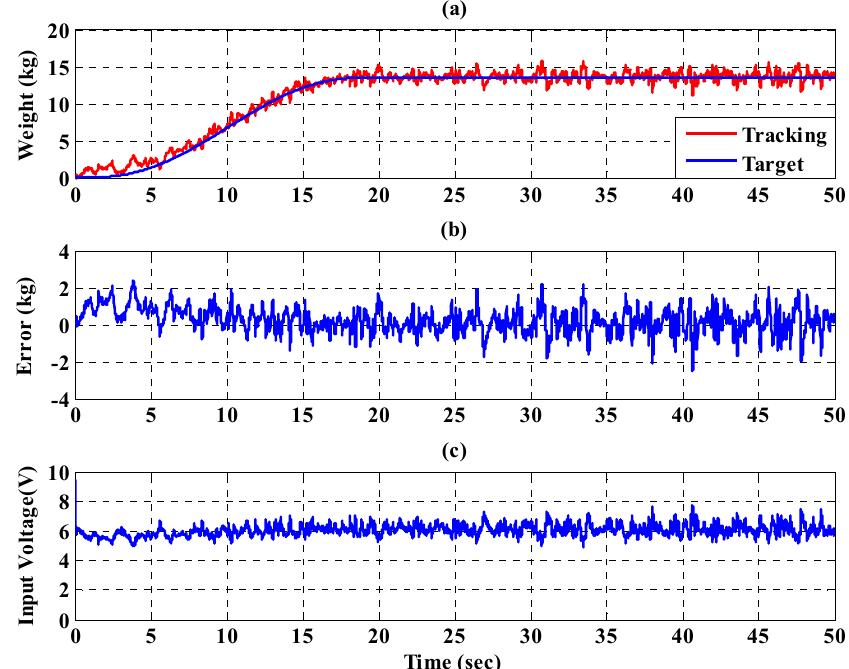
Figure 23. Experimental results for the PBWSS with a dynamic bodyweight unloading force of 20% (13.6 kg) in 50 s. ( a ) Tracking trajectory; ( b ) tracking error; ( c ) control voltage.